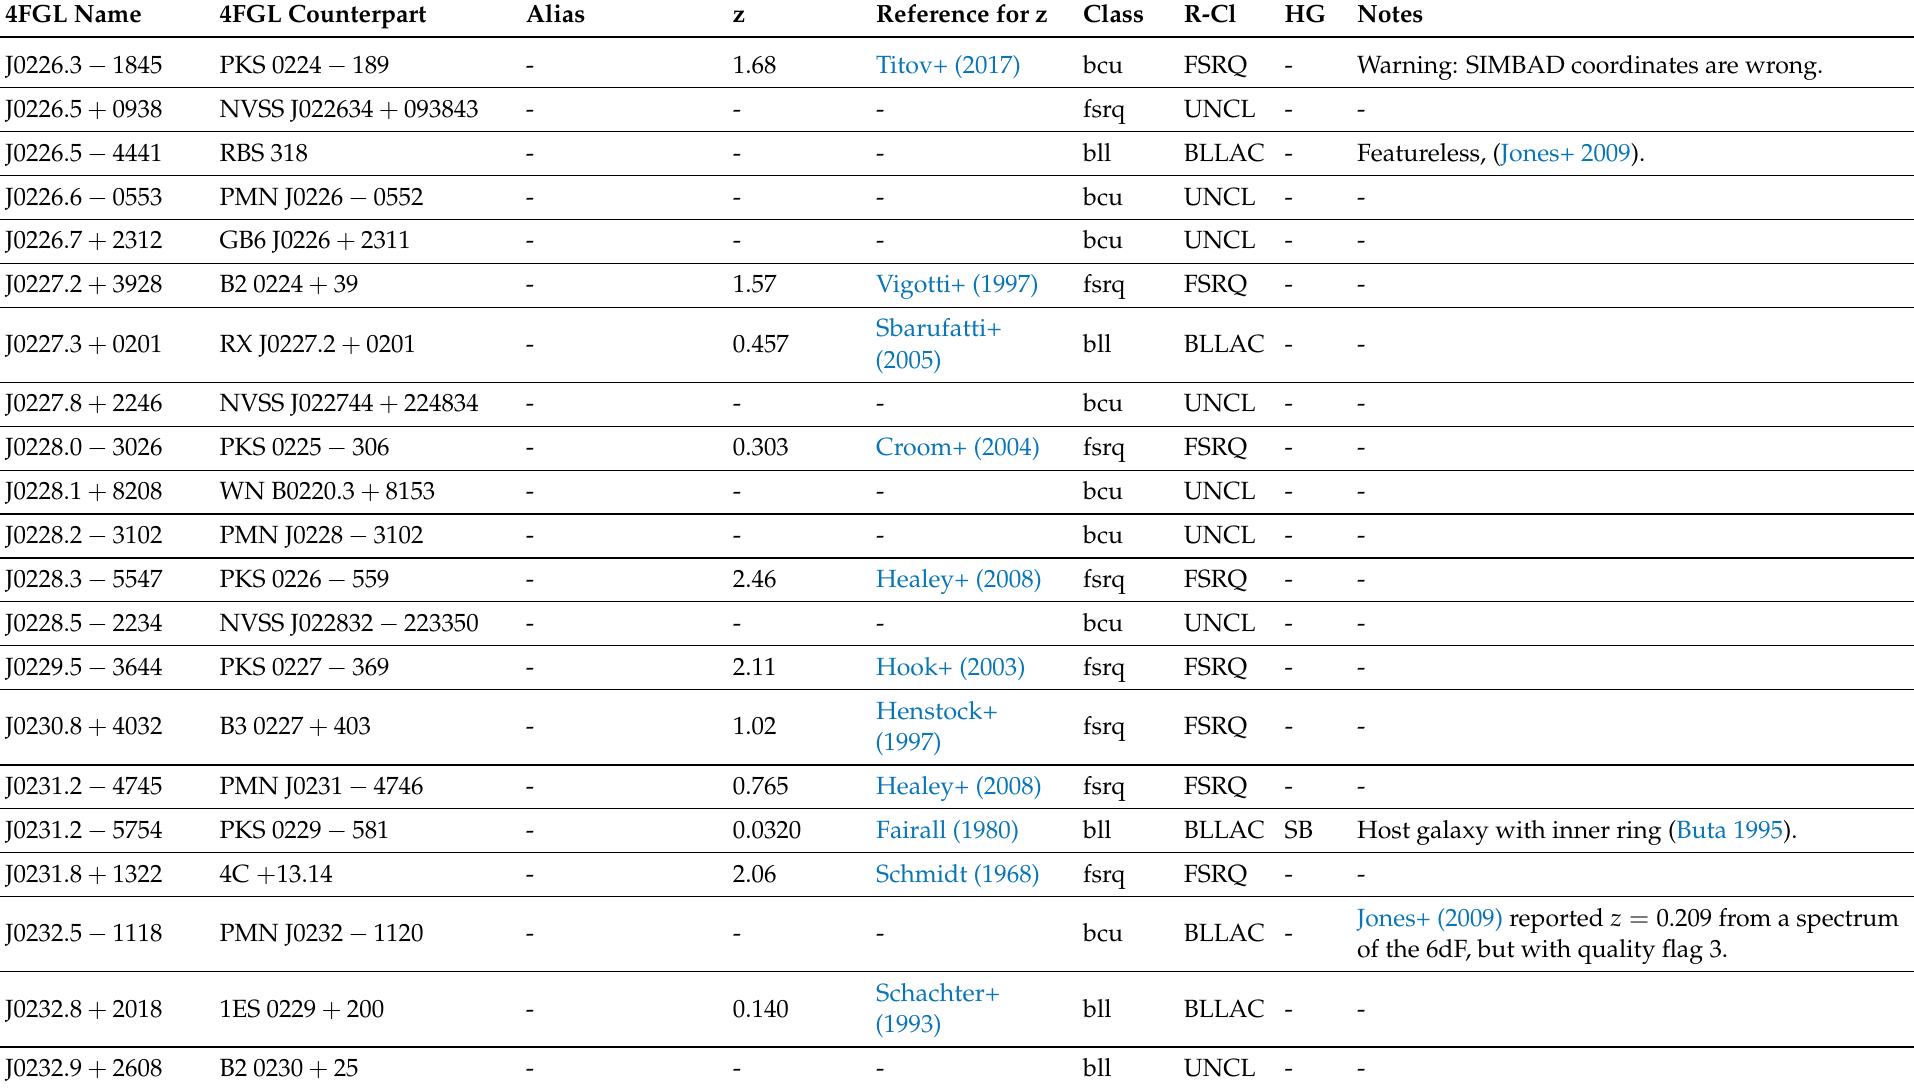
Warning: SIMBAD coordinates are